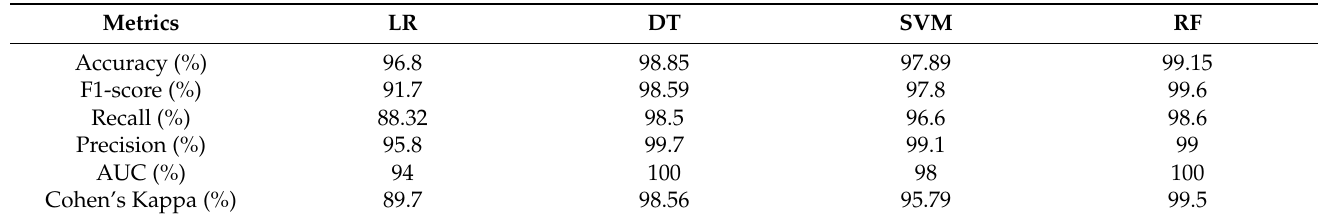
Table 8. Performance analysis of the BR/EDR IDS using supervised–ML